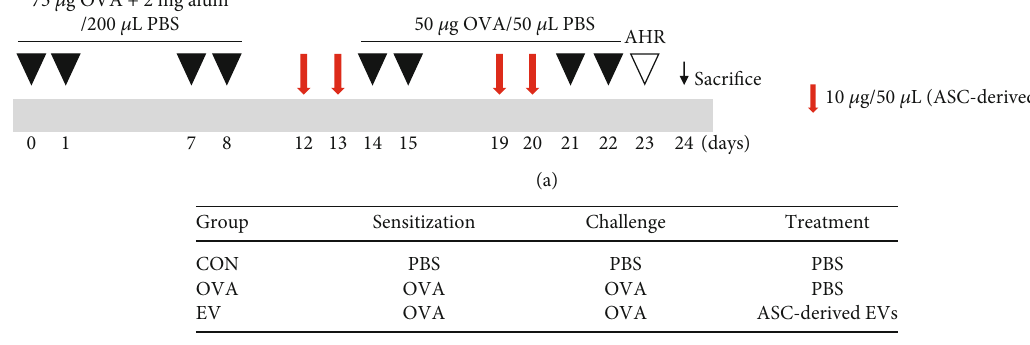
Figure 1: Experimental protocol of this study. (a) Mice were sensitized on days 0, 1, 7, and 8 by intraperitoneal injection of ovalbumin (OVA) and challenged intranasally on days 14, 15, 21, and 22 with OVA. Adipose stem cell- (ASC-) derived extracellular vesicles (EVs) (10 μ g/50 μ L) were injected intranasally on days 12, 13, 19, and 20. (b) Mice were divided into three groups according to sensitization, challenge, and